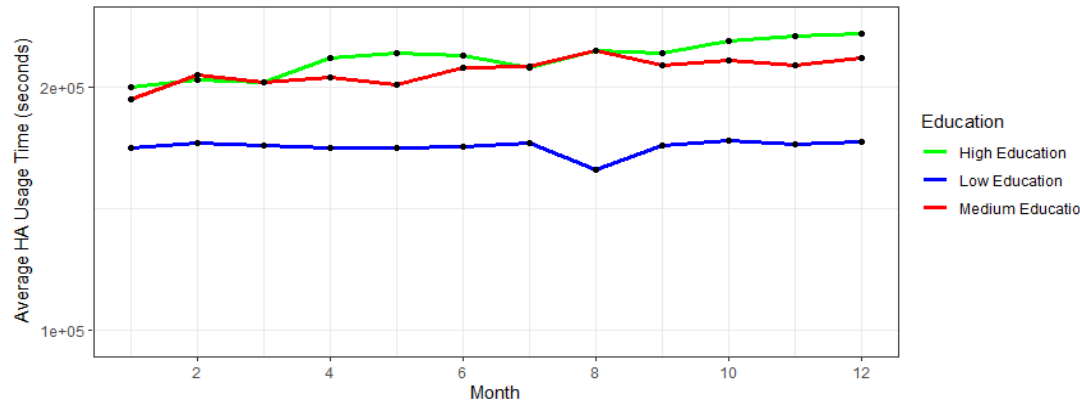
Figure 5. Average HA usage per age group per month.